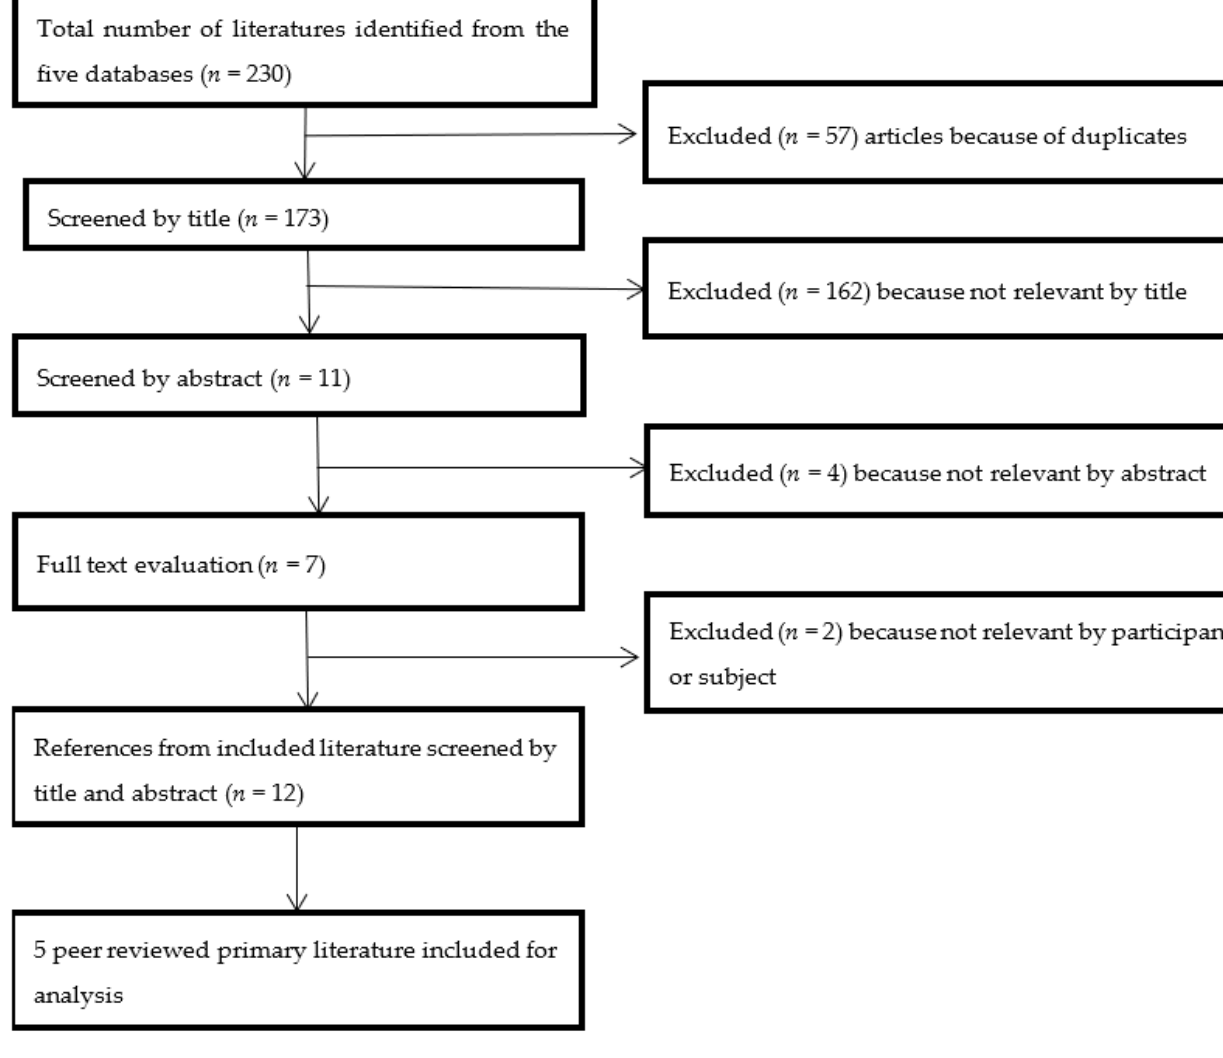
Figure 2. Article selection process.